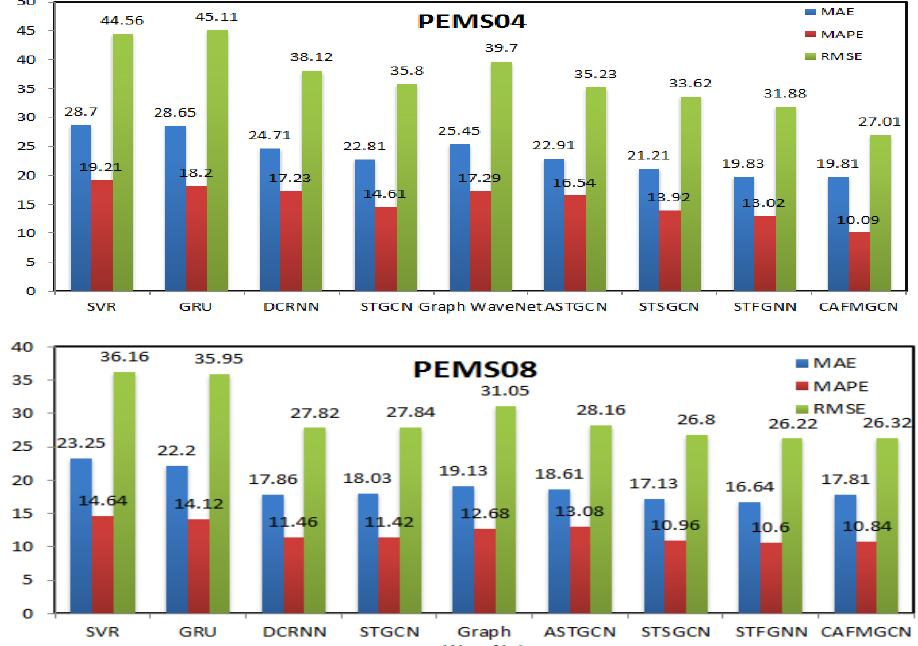
Figure 9. Average prediction results of different methods.